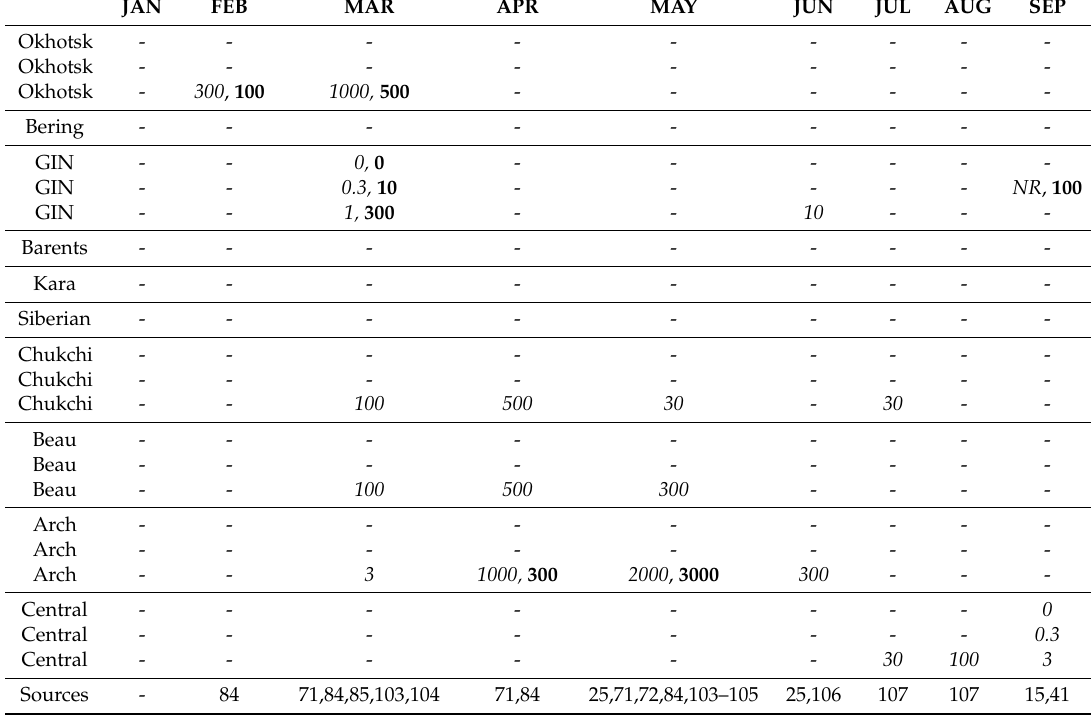
Table 1. Selected Arctic sea ice chlorophyll and dissolved organic carbon data, by region as in Figure 1. Measured chlorophyll in italics and mg/m 3 , dissolved organic carbon (DOC) presented in bold as micromolar carbon. In each cell, the top, middle and bottom rows represent upper ice habitats, the interior and the bottom layer. Abbreviations: (GIN) Greenland Iceland Norway Seas, (NR) not reported, (Beau) Beaufort Sea but mainly coastal, (Arch) Canadian Archipelago. Where bottom layer data are given in the literature as mg/m 2 , a three-centimeter thickness is adopted for